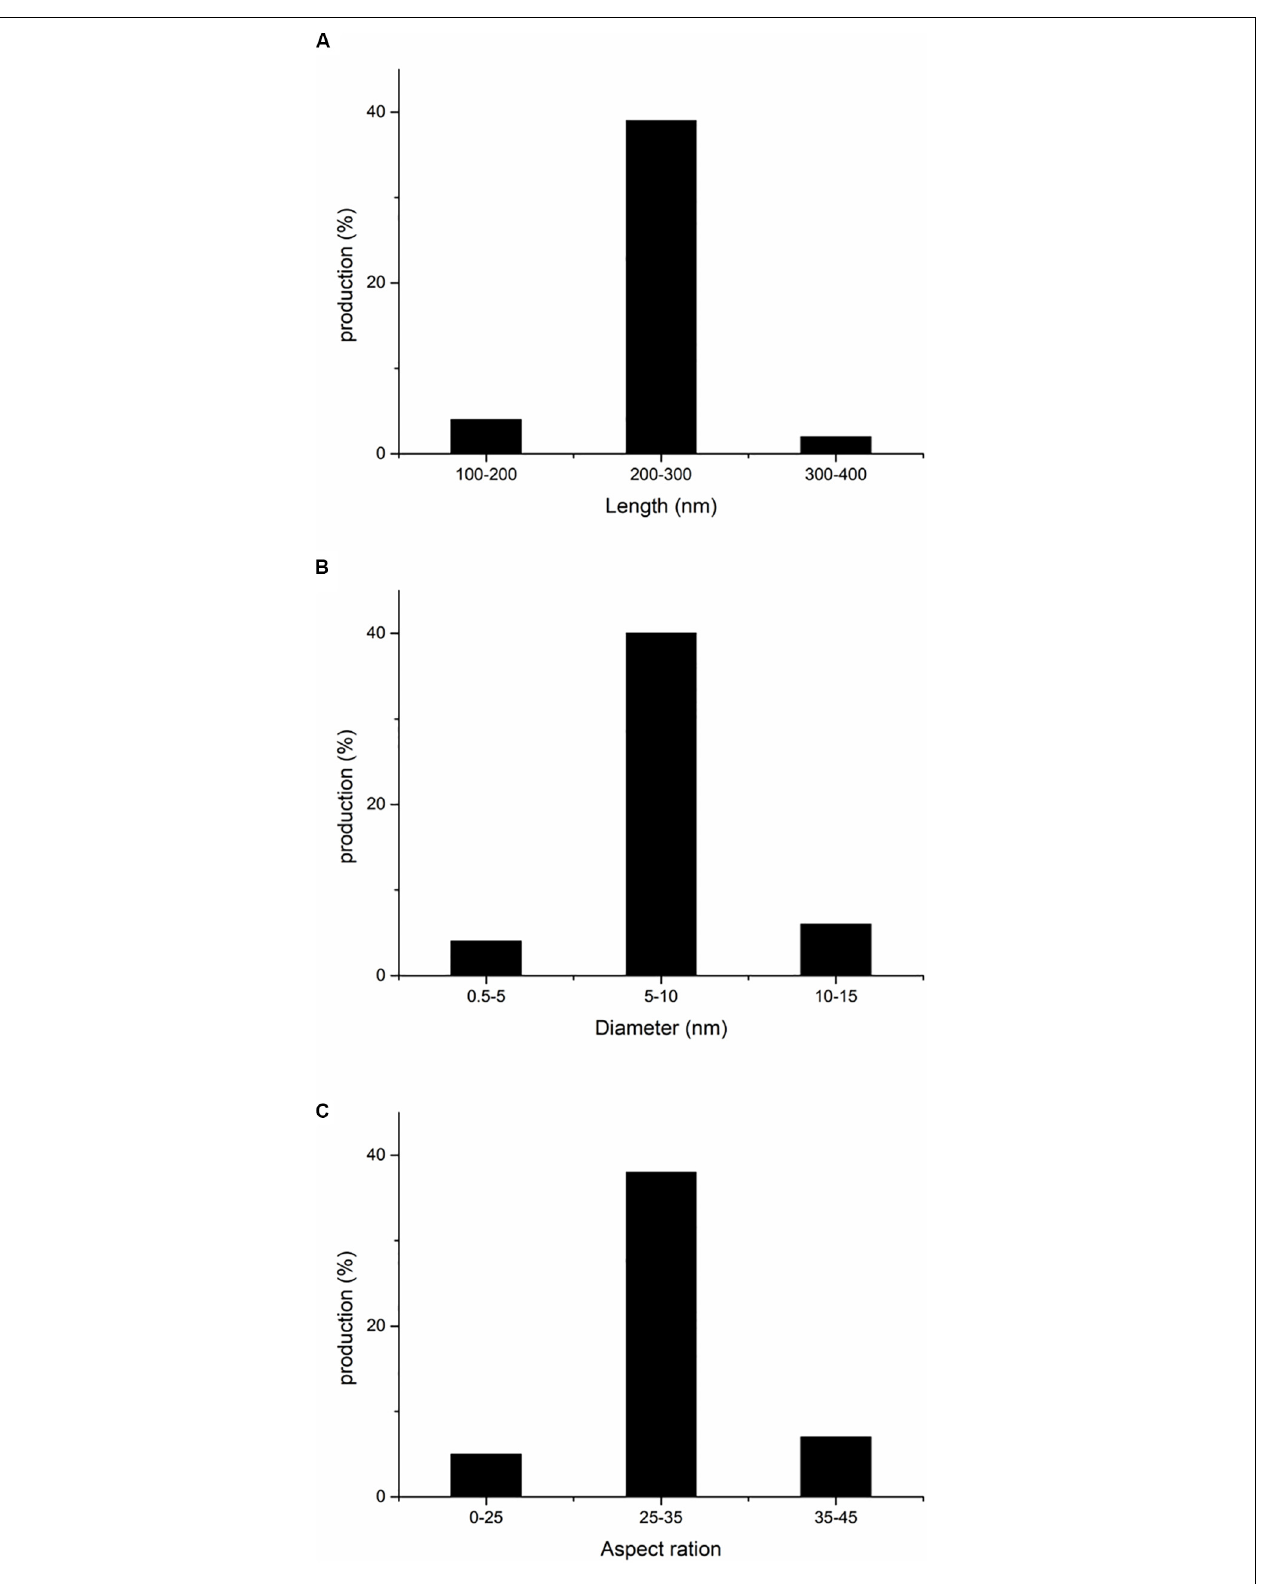
Frontiers in Bioengineering and Biotechnology | www.frontiersin.org